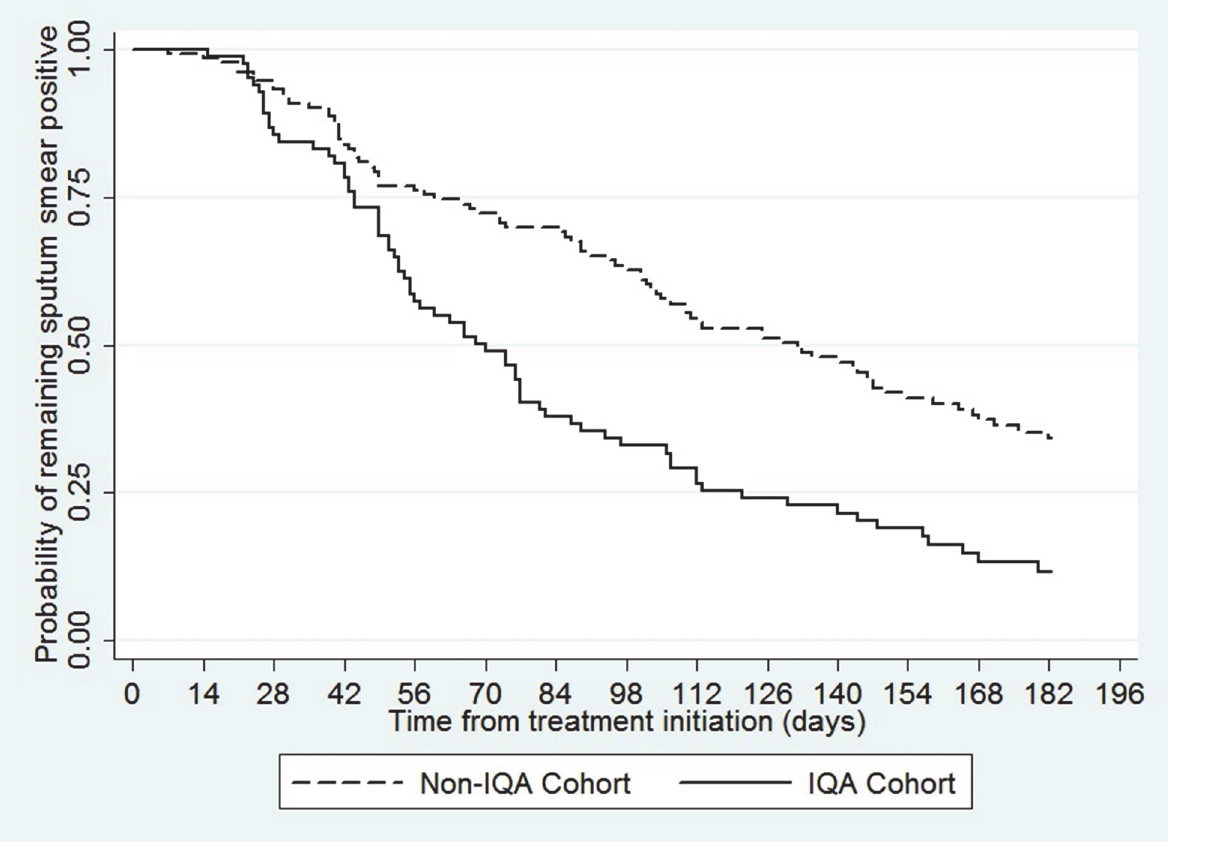
Fig 2. Kaplan-Meier curve showing time to smear conversion by cohort (n =